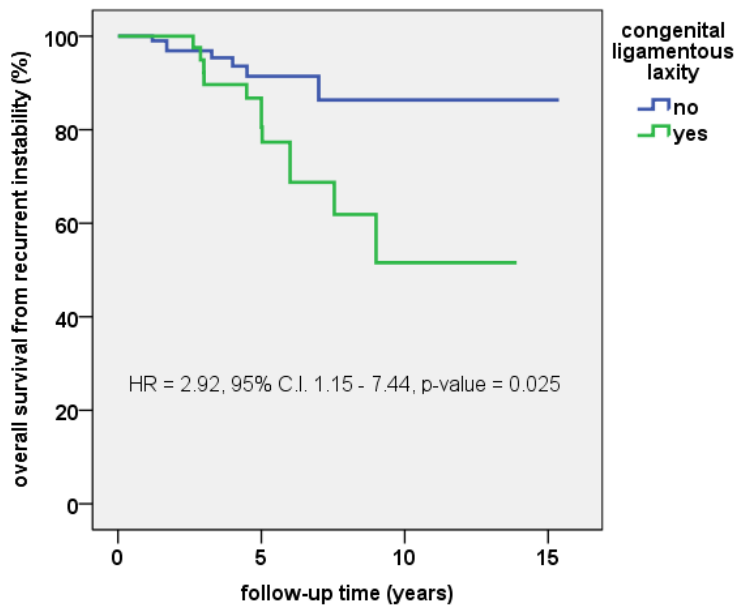
Figure 4. Kaplan–Meyer survival curve free from recurrent instability in children with and without Figure 4. Kaplan – Meyer survival curve free from recurrent instability in children with and with- syndromic congenital ligamentous laxity. HR = hazard ratio; C.I. = confidence out syndromic congenital ligamentous laxity. HR = hazard ratio; C.I. = confidence interval.